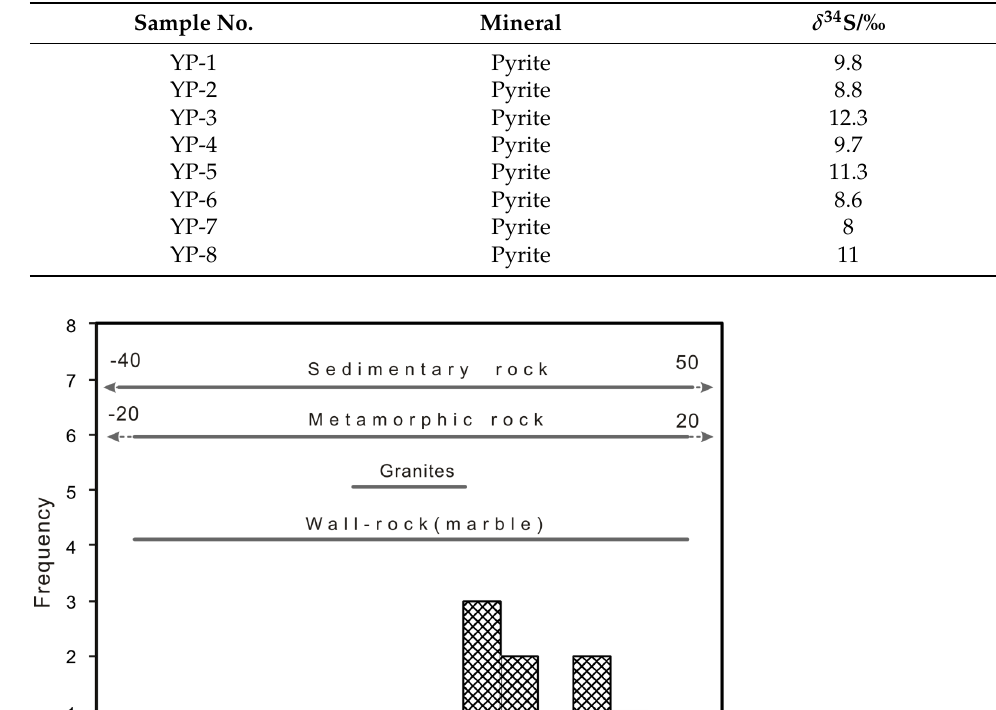
Table 2. Sulfur isotopic data of ore-bearing pyrite from the Lijiapuzi gold deposit. Sample No.